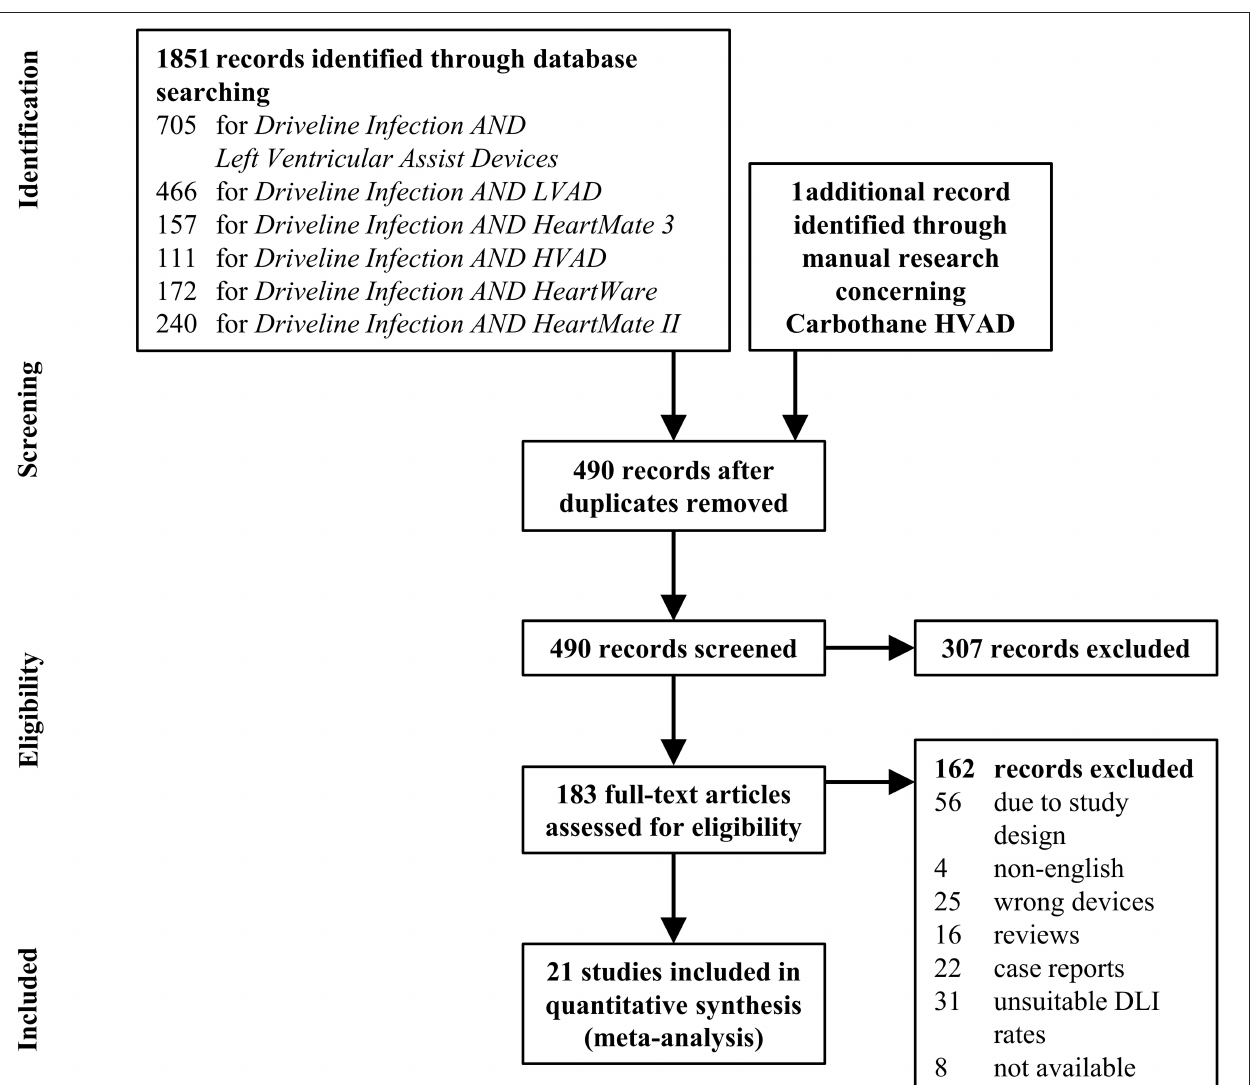
FIGURE 1 | Flow diagram summarizing the systematic research process. DLI, driveline infection.